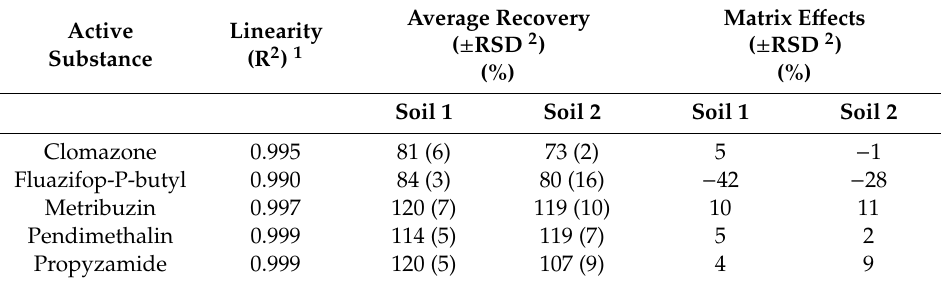
Table 5. Validation parameters for herbicide active substances in two kind of soils (GC- µ